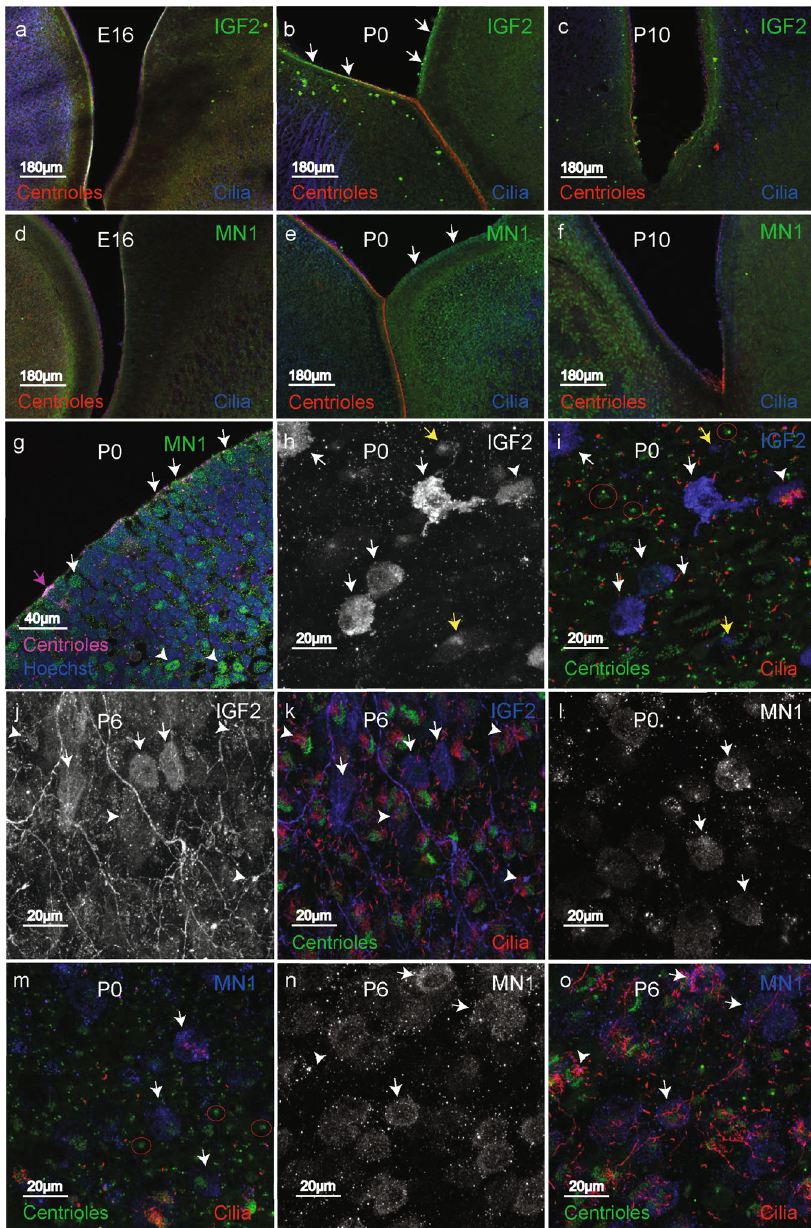
Fig. 6 MN1 and IGF2 are expressed by differentiating ependymal cells in the P0 to P6 mouse ventricular zone. a – g Immuno fl uorescence stained embryonic (E16), newborn (P0) and postnatal day 10 (P10) mouse brain coronal sections are shown. a , c , d and f In E16 and P10 coronal sections MN1 and IGF2 staining is not apparent. b IGF2 staining is seen in the ventricular zone of the medial and lateral ventricular walls in P0 animal brains (arrows). e MN1 labels immature ependymal cells in the P0 lateral ventricular wall covering the striatum on the right (arrows). The medial wall ependyma are mature and demonstrate multiple centrioles (red) and motile cilia (blue). MN1 staining is not evident in these cells. g High power image of P0 lateral ventricular wall showing green MN1 staining of immature ependymal cell nuclei and cytoplasm (white arrows) and more basally located striatal cells (arrowheads), which could explain the cortical or juxtacortical location of MN1-BEND2 tumors. The pink arrow indicates a more mature differentiating ependymal cell demonstrating multiple centrioles (pink fl uorescence). h , i P0 whole mounts of the lateral ventricular wall show IGF2-positive microglia situated on the ependymal surface (arrows). An IGF2-positive, late differentiating ependymal cell with short multiple cilia is indicated by the arrowhead. Earlier stage differentiating ependymal cells with focal IGF2 staining are indicated by yellow arrows. Red circles highlight very early “ halo stage ” differentiating ependymal cells ( i , l ), which are IGF2-negative ( i ). j , k In P6 whole mount lateral wall, IGF2 again stains microglia (arrows) and immature ependyma with short cilia (arrowheads). l , m Mostly unciliated differentiating ependymal cells show MN1 staining in the P0 lateral wall (arrows). Very early halo stage nascent ependyma are MN1-negative ( l ). n , o In P6 lateral wall, differentiating ependymal cells with few cilia are MN1-positive (arrows). A later differentiating multiciliated ependymal cell is MN1-negative (arrowhead). Experiments were performed twice with equivalent results.